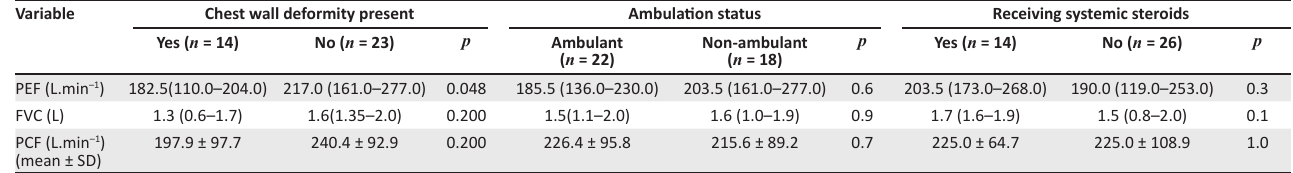
TABLE 3: Comparison of participant characteristics and pulmonary function measures. Variable Chest wall deformity